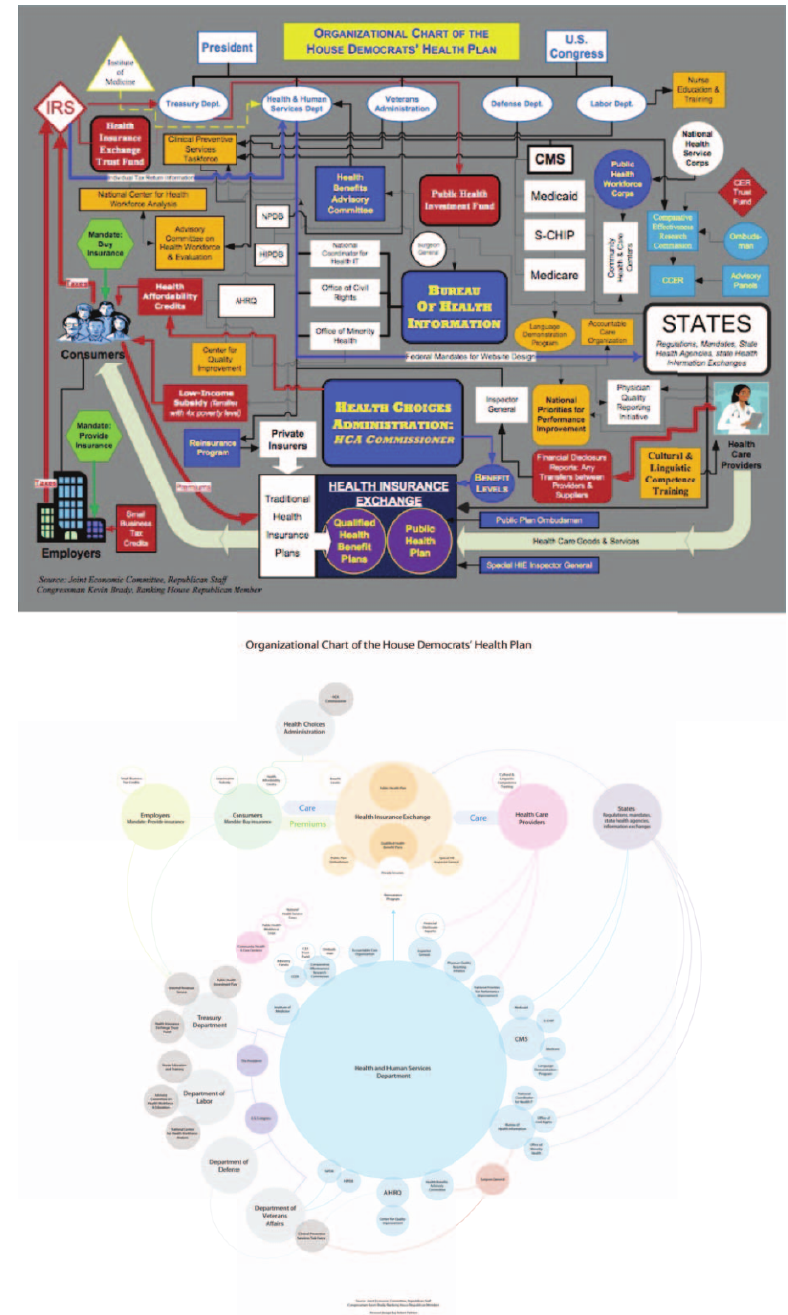
Figure 16. Hullman and Diakopoulos demonstrate how data can be window dressed to change the viewers opinion of it. These two images visualize the same data but each illustrator has different intended outcomes. The top image shows an unstructured, complicated graph of conflicting colors and shapes, clearly intended to confuse and obstruct the data, whereas the bottom lays the data out in a simple fashion using consistent shapes and colors [37]. Image courtesy of Hullman and Diakopoulos